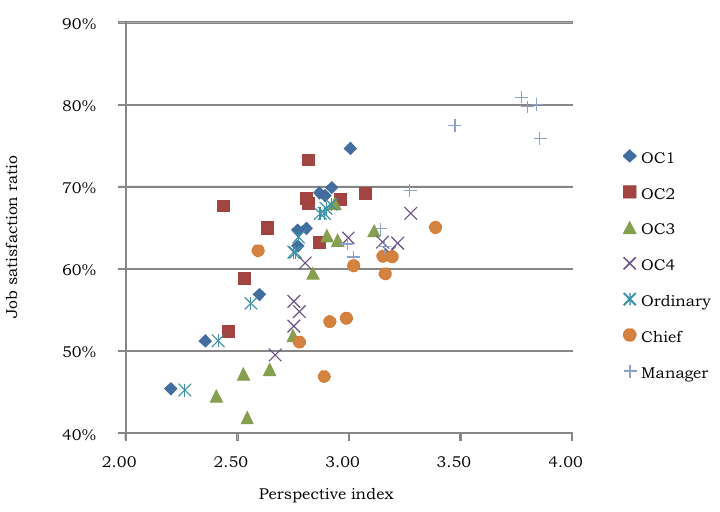
Figure 5. Perspective index by occupational and rank categories and annual transitions in job satisfaction ratio Note: Survey X data taken from 2004 to 2013, N =